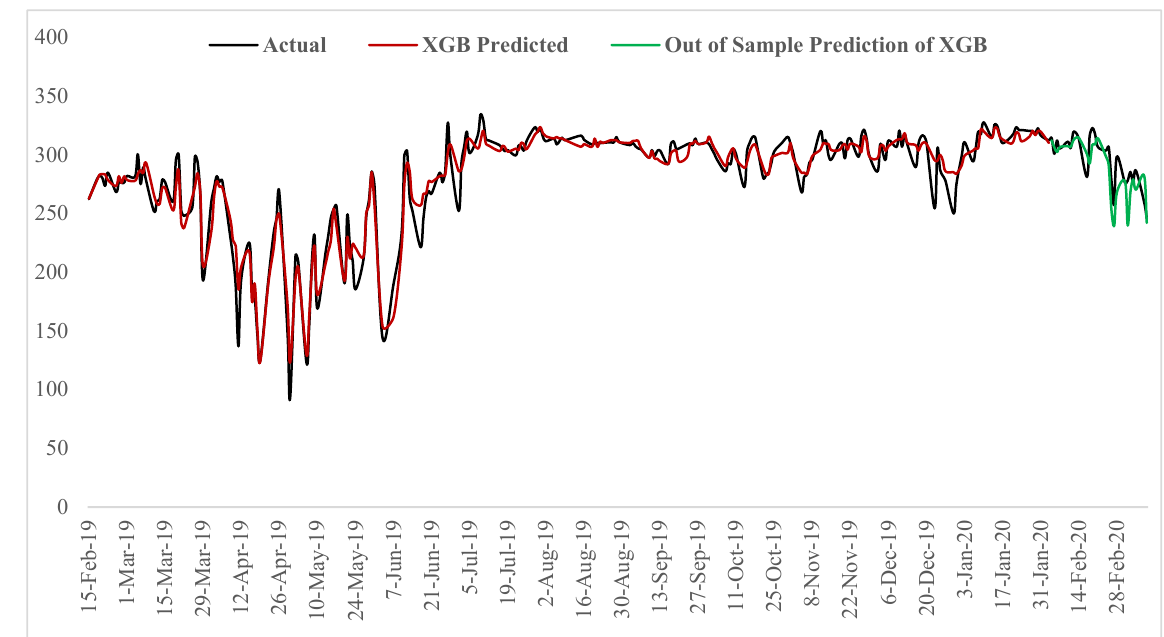
Figure 7. Actual and predicted values in the pre-pandemic period.